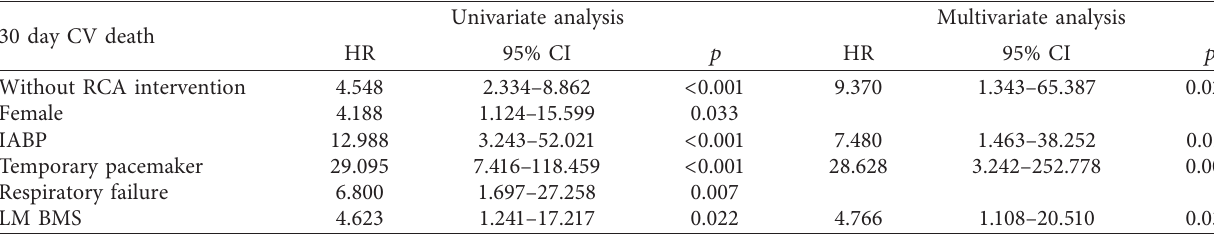
Table 3: Cox regression for the 30-day cardiovascular